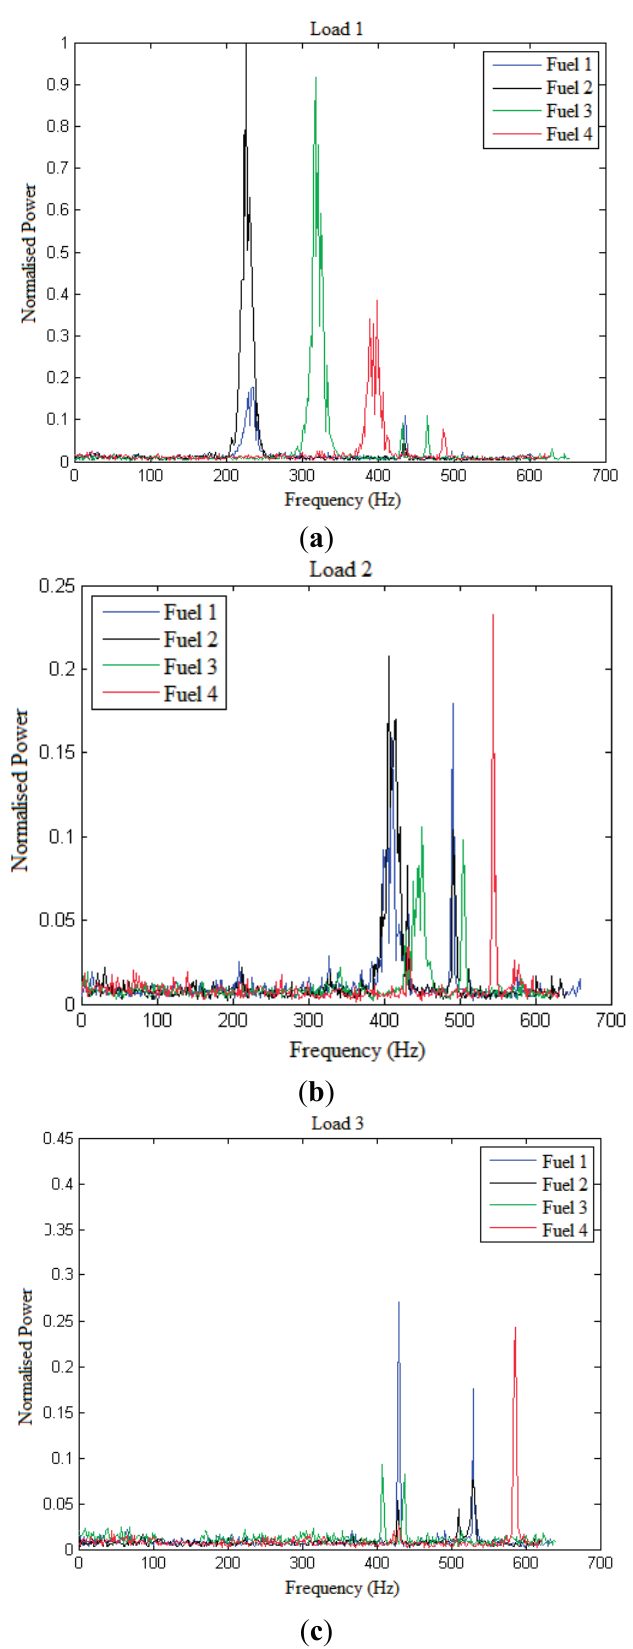
Figure 6. Comparison of normalized power spectra for different fuels for ( a ) Load 1, ( b ) Load 2, and ( c ) Load